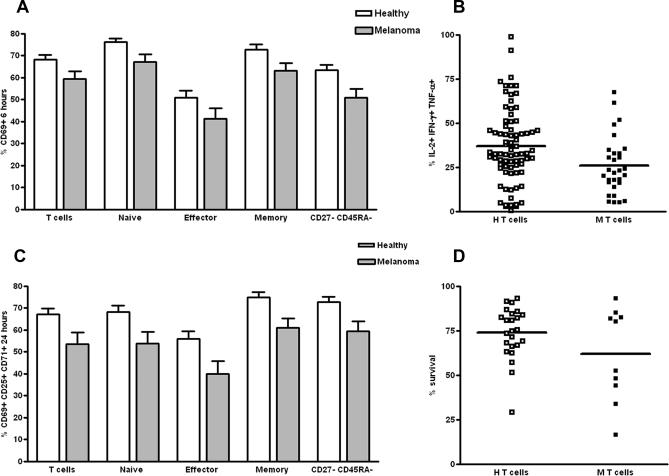
Activation and Survival of CD8 and CD4 T Cells in Response to Activating StimulusLymphocytes from patients with IFN-nonresponsive melanoma and healthy donors were stimulated with beads coated with anti-CD3 and anti-CD28 antibodies.(A) Percentage of CD8 and CD4 T cells expressing CD69 at 6 h following stimulation (mean and standard error).(B) Percentage of CD8 and CD4 T cells expressing CD69, CD25, and CD71 (data combined) at 24 h following stimulation (mean and standard error).(C) Percentage of CD8 and CD4 T cells expressing IL-2, TNF-α, and IFN-γ (data combined) at 24 h following stimulation.(D) Percentage of surviving (Annexin V-negative 7-AAD-negative) cells at 4 d following stimulation. Means are indicated by the bar in scatter columns.